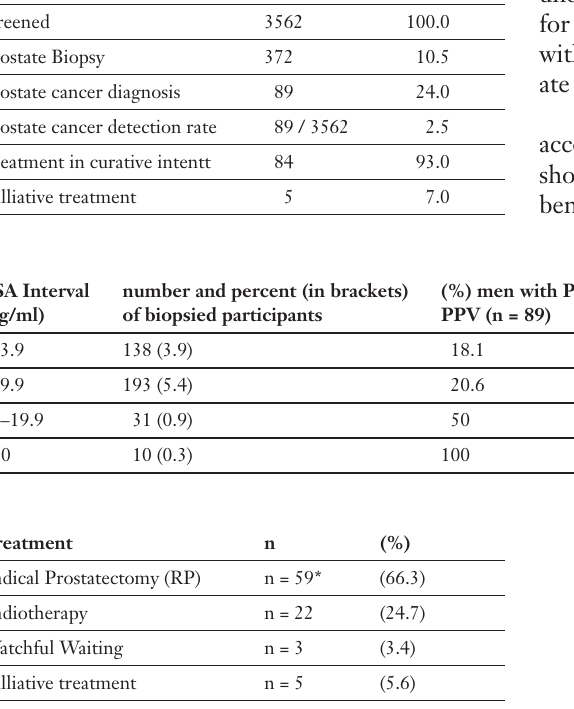
Results of screening investigations.